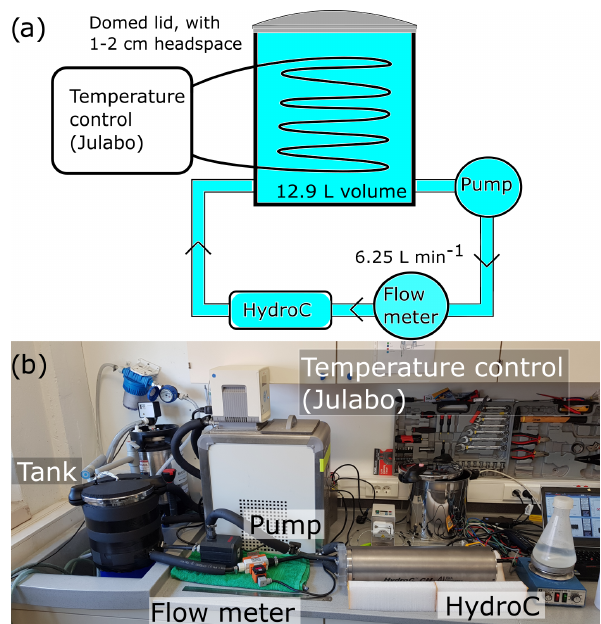
Figure B1. (a) Schematic representation of the experiment setup and (b) picture of the experiment setup. The tank had an airtight dome-shaped lid with a small headspace ( ∼ 0 . 3L) and was 27.5cm high and 24.5cm diameter. Room temperature was controlled and kept